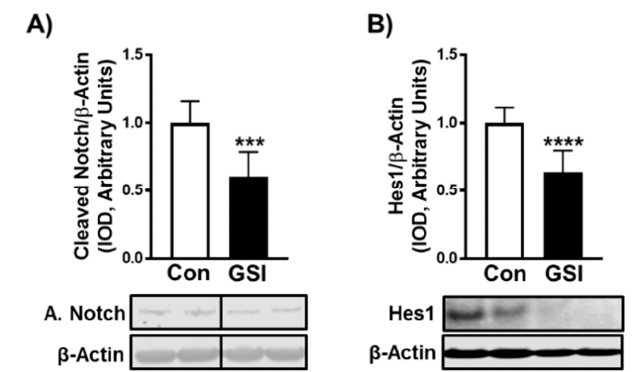
Figure 1. GSI reduces Notch signaling in di ff erentiating C2C12 myotubes. ( A ) NICD / β -Actin; ( B ) Hes1 / β -Actin expression (Integrated optical density, IOD) in 96-h myotubes treated with or without 4 µ m γ -secretase inhibitor (GSI) every 12 h. Thirty minutes prior to collection all cells were treated with 1 µ m puromycin. For representative image: lanes 1 and 2 are Con; lanes 3 and 4 are GSI. Data were analyzed using a Student’s T-test. *** p < 0.001 vs. Control (Con). **** p < 0.0001 vs. Con ( n = 3 experiments). Data are mean ±